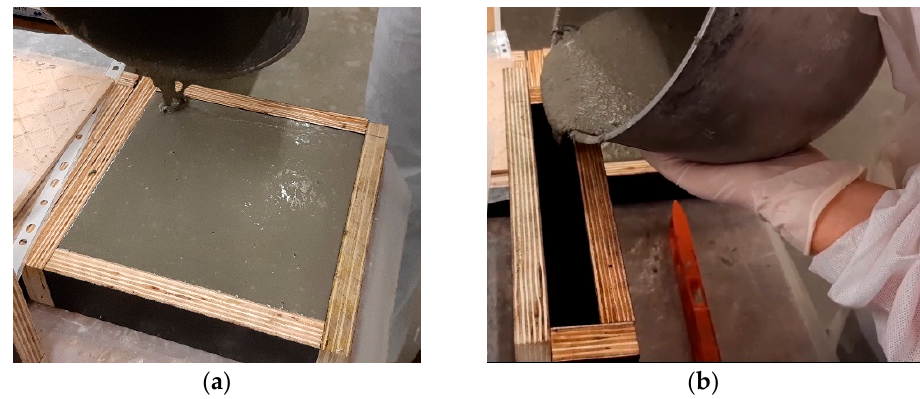
Figure 7. Inductance measurements were taken on both surfaces of each specimen: one casting surface and one moulded surface, in the case of horizontal specimens, and two moulded surfaces in vertical specimens. Additionally, a polishing machine was used in the casting surface of horizontal specimens to reduce their roughness (smoothed surface), and testing conditions and specimen referencing are detailed in Table 4.